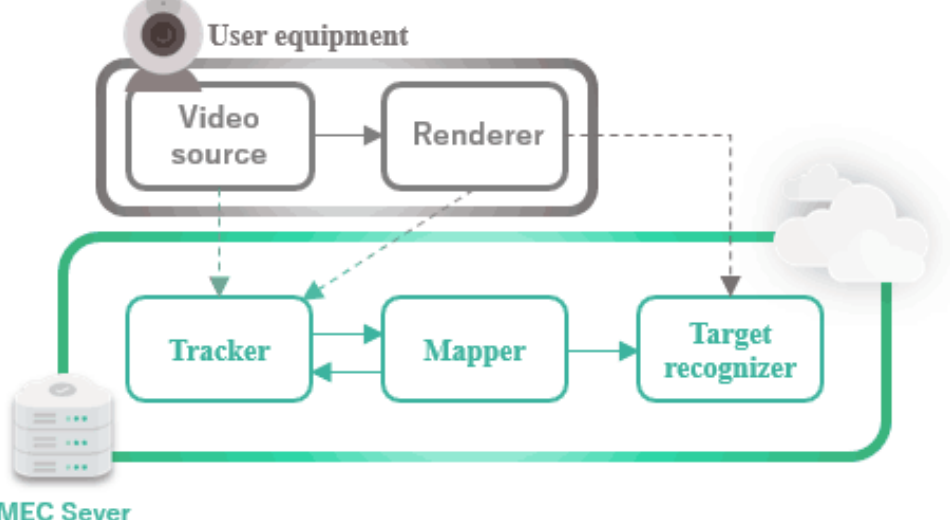
Figure 1. An offloading example of a task